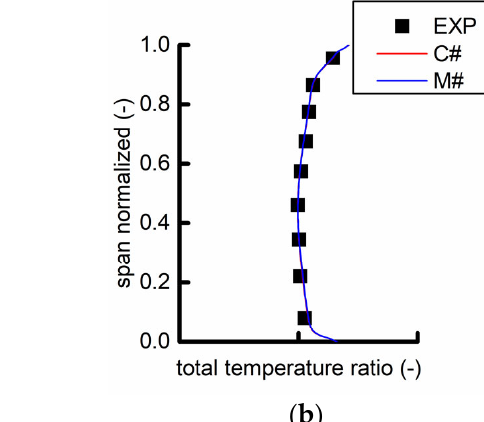
Figure 13. Results of unsteady calculation and test. ( a ) Total pressure ratio ( b ) Total temperature ratio.